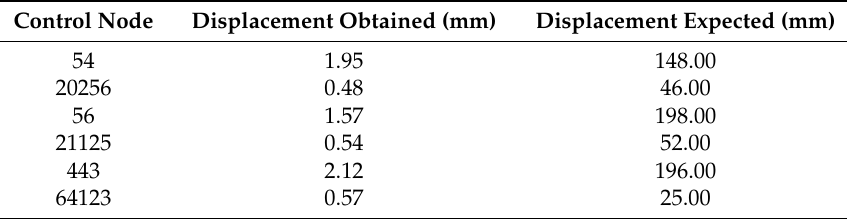
Table 5. Comparison between the obtained and expected displacement of the control nodes in the numerical model (initial